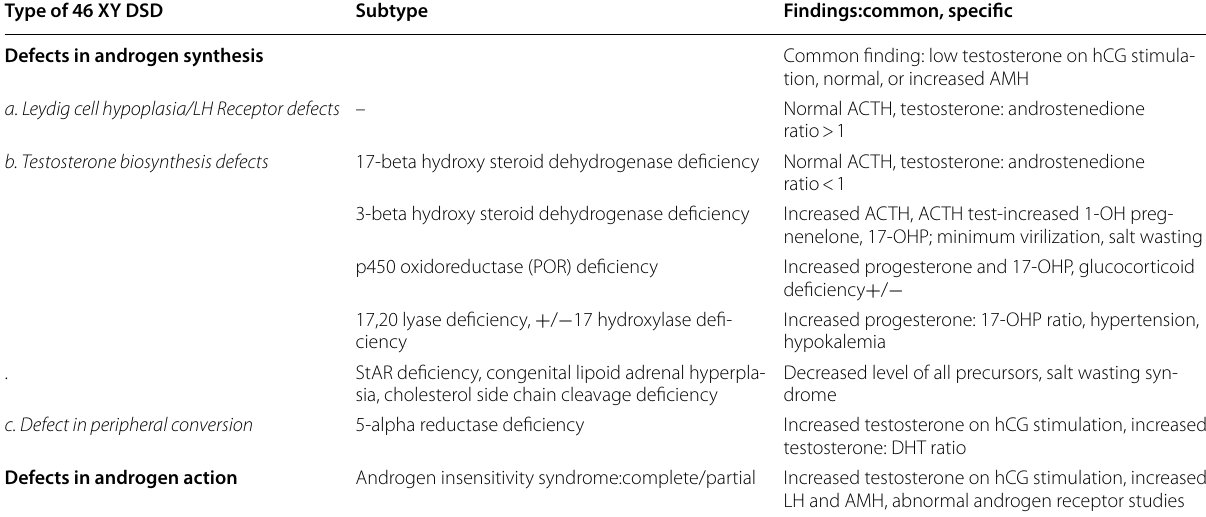
Table 4 The further characterization of 46 XY DSD, based on endocrine and genetic studies Type of 46 XY DSD